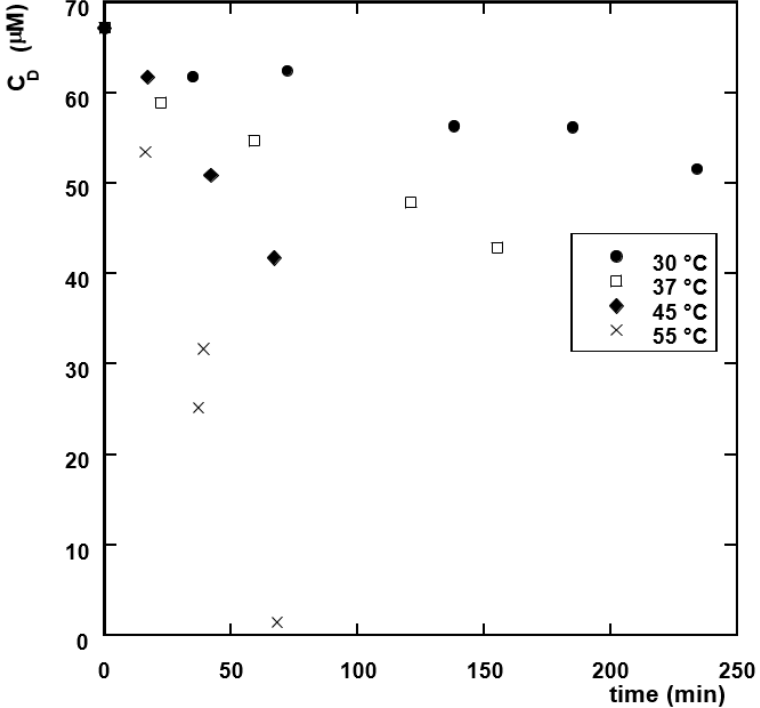
Figure 6. Diuron degradation kinetics profiles in the presence of PDS (4.5 g L −1 ) at different temperatures; initial pH = 3.8.